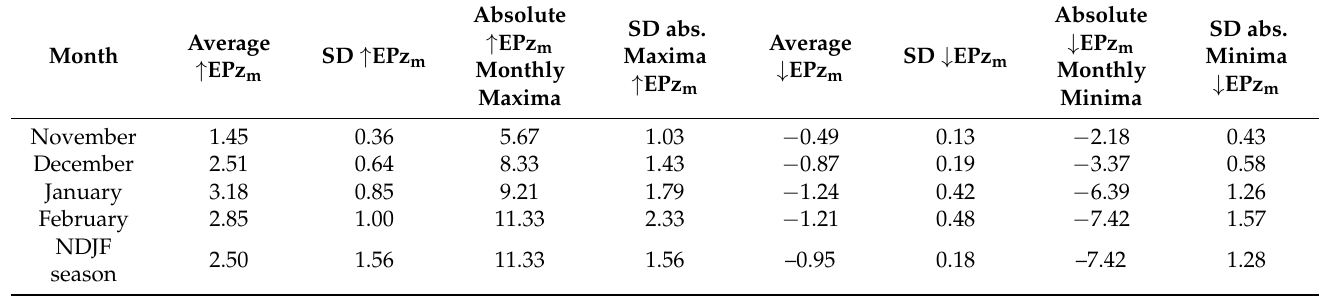
Table 1. The average ↑ EPz m (left) and ↓ EPz m (right) values and their absolute extremes for each month and their standard deviations (SD).